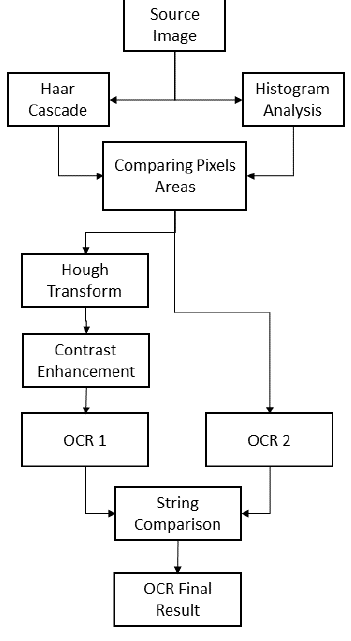
Figure 1. Photo processing algorithm